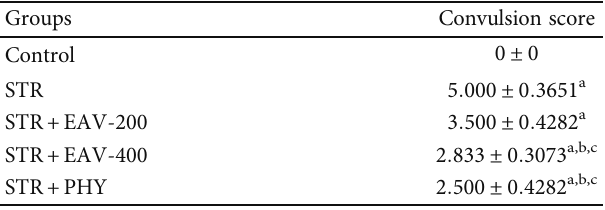
Table 6: Impact of EAV-200, EAV-400, and PHY on convulsion